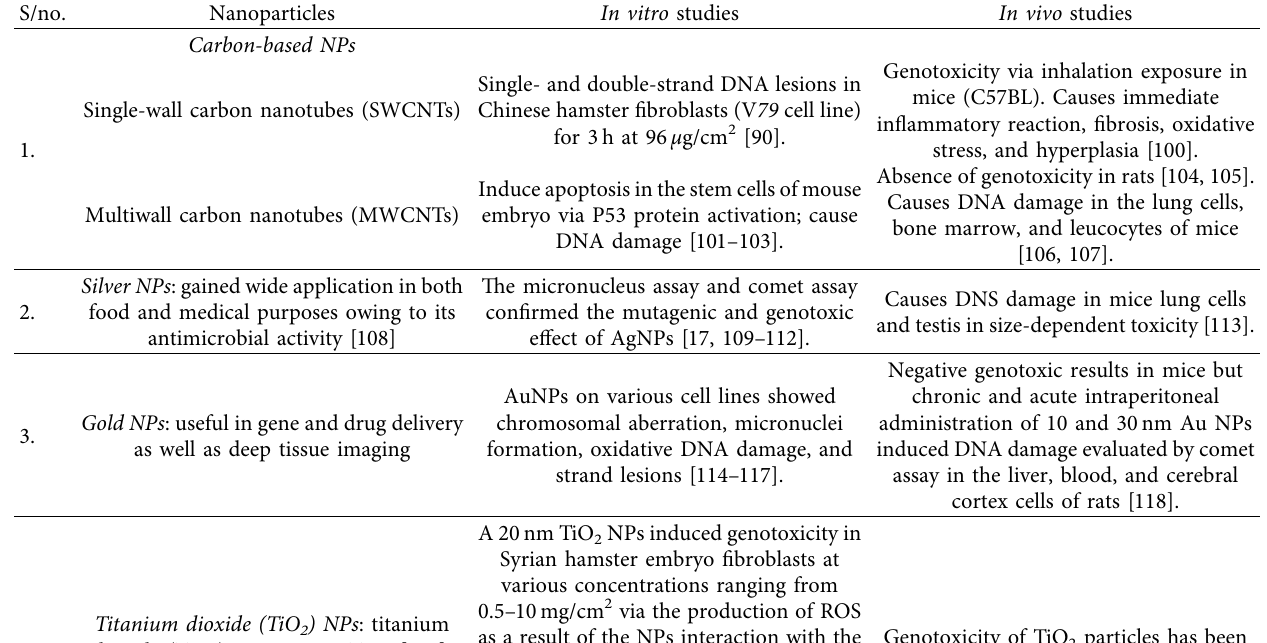
Table 2: In vitro and in vivo studies for the genotoxic effect of